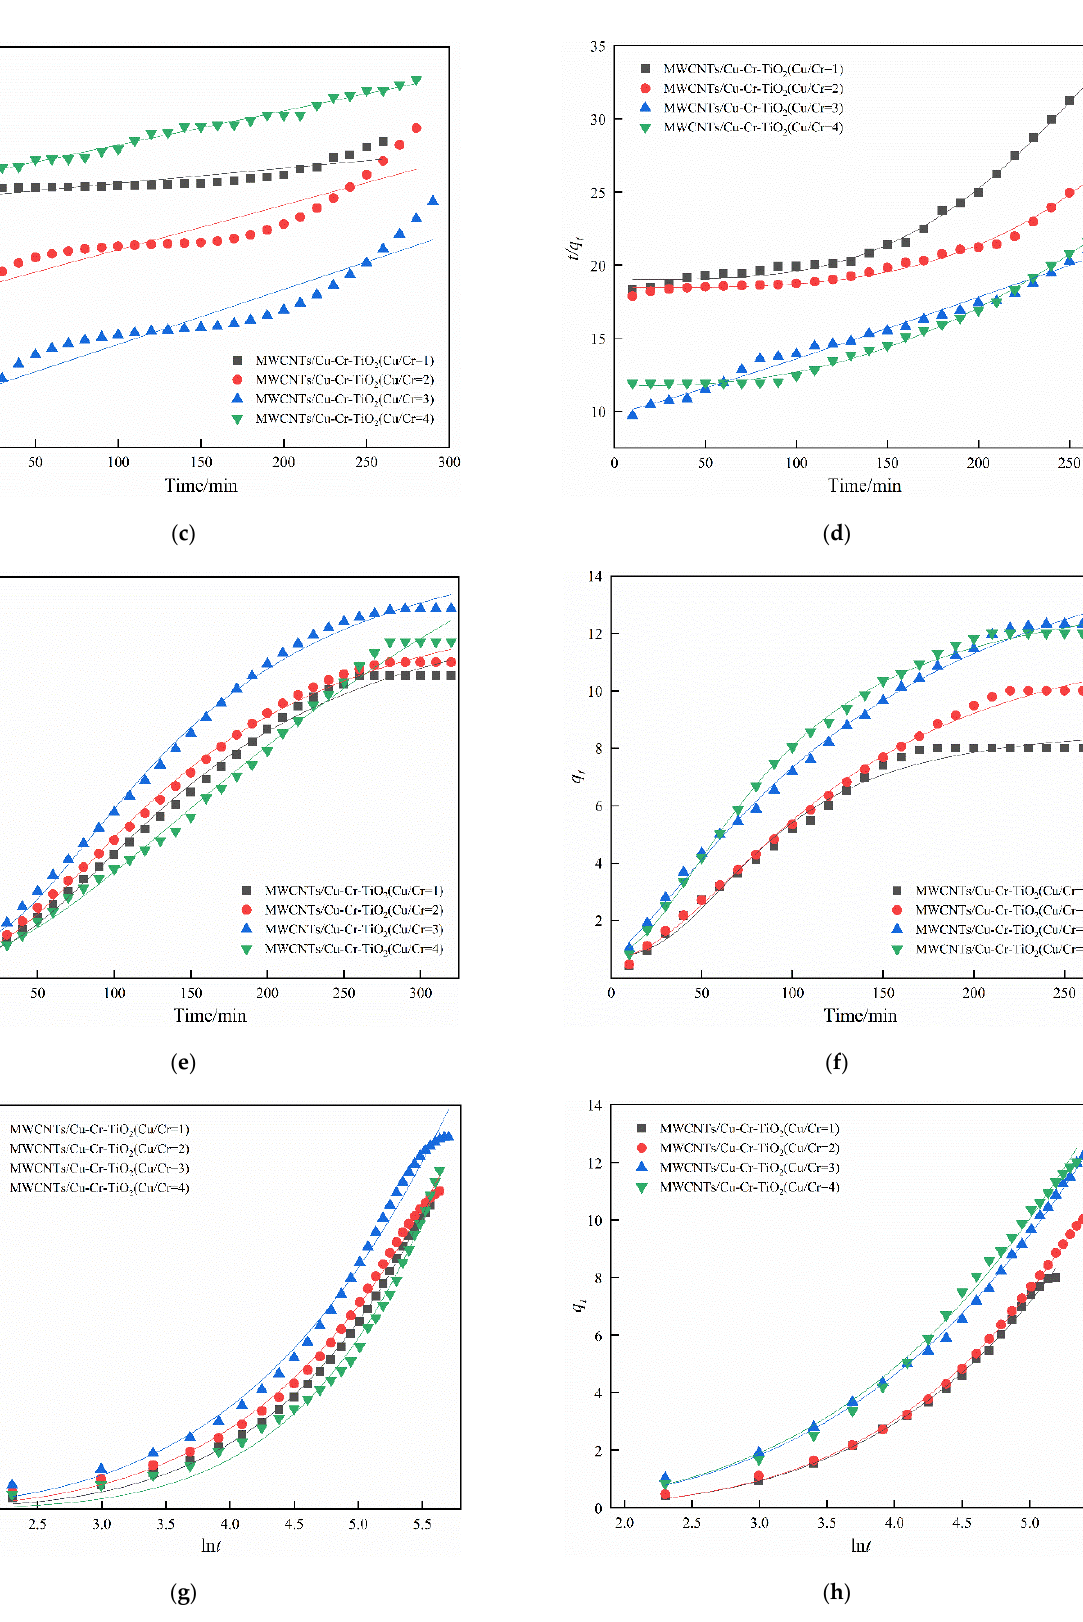
Figure 12. The results of different models. ( a ) Pseudo-first-order model for the adsorption of SO 2 ; ( b ) pseudo-first-order model for the adsorption of NO; ( c ) pseudo-second-order model for the adsorption of SO 2 ; ( d ) pseudo-second-order model for the adsorption of NO; ( e ) Bangham model for the adsorption of SO 2 ; ( f ) Bangham model for the adsorption of NO; ( g ) Elovich model for the adsorption of SO 2 ; ( h ) Elovich model for the adsorption of NO.